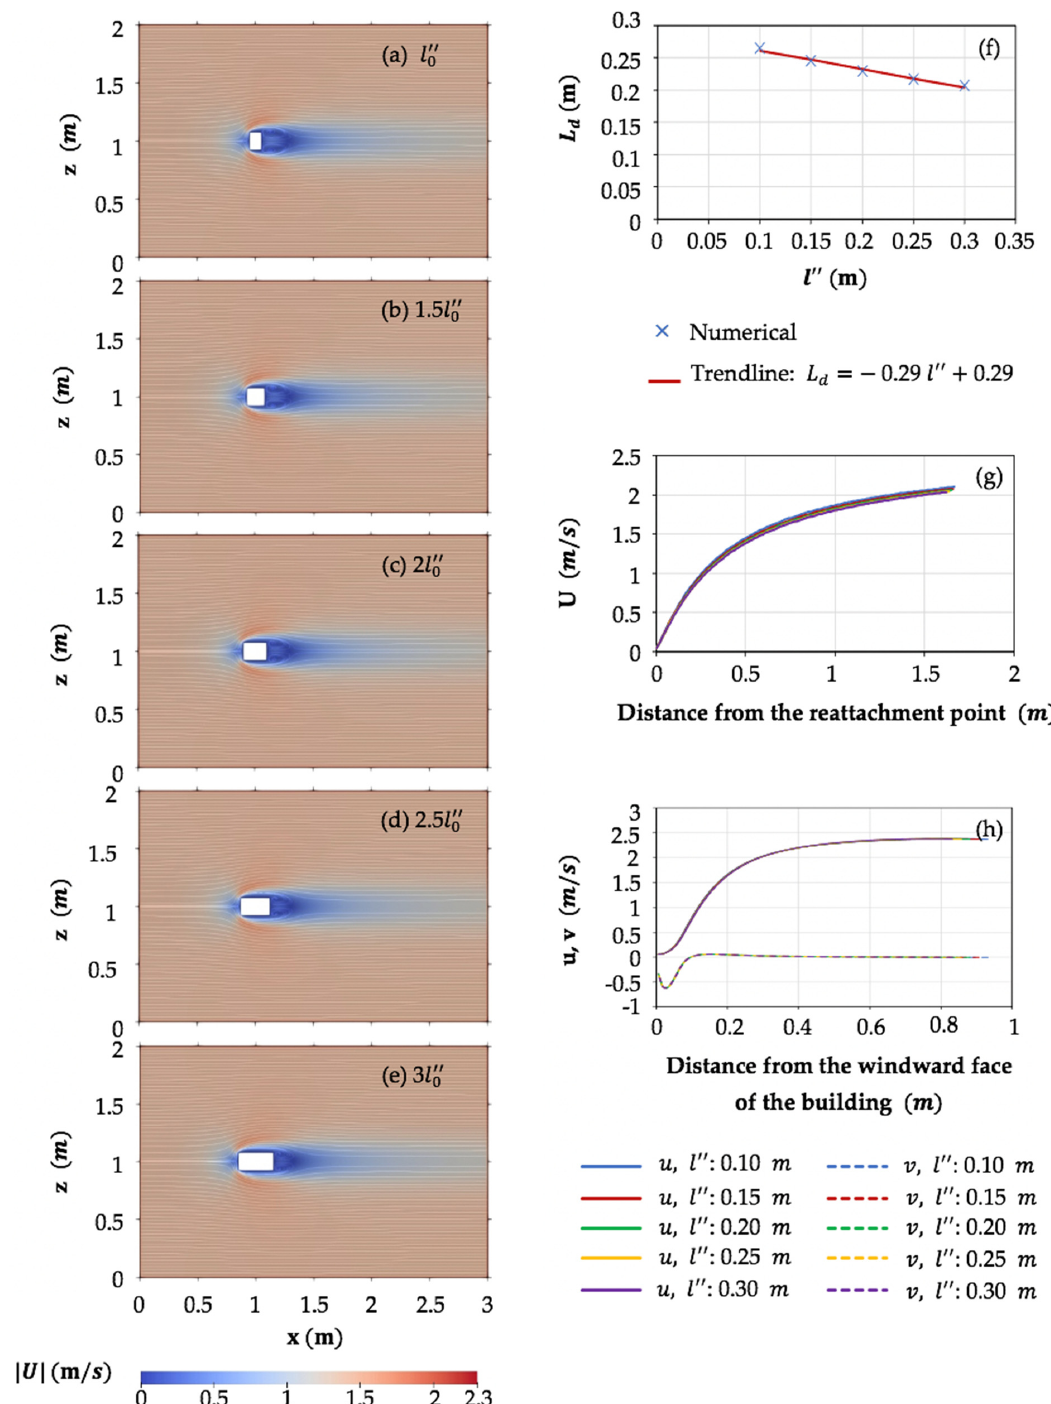
Figure 5. The impact of building length on ( a – e ) wind velocity magnitude (color) and direction (streamlines), ( f ) length of the downwind recirculation region, L d , just behind the leeward face of the building along the centerline, ( g ) wind velocity magnitude downstream of the building after flow reattachment along the centerline, and ( h ) streamwise, u , and vertical wind velocity components, v , upstream of the building along the centerline. Results are derived for a horizontal near-surface plane, y = 0.0125 m. The building width and height are w (cid:48)(cid:48) and h (cid:48)(cid:48) , respectively. The building length, l (cid:48)(cid:48) , is 0 0 varied as l (cid:48)(cid:48) , 1.5 l (cid:48)(cid:48) , 2 l (cid:48)(cid:48) , 2.5 l (cid:48)(cid:48) , and 3 l (cid:48)(cid:48) 0 0 0 0 0